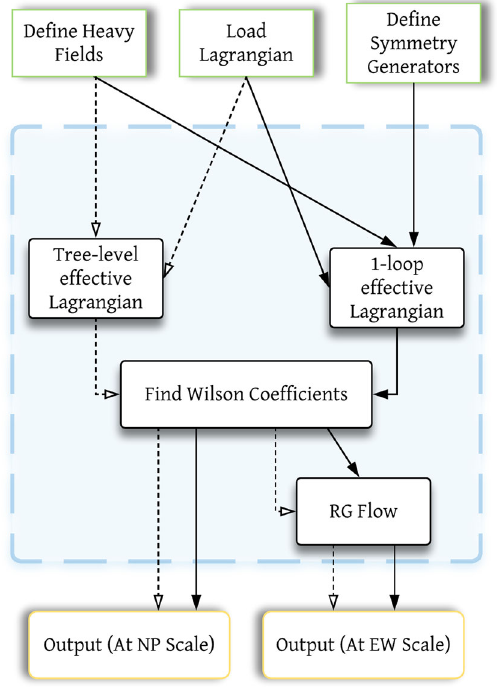
Fig. 1 Flow-chart for